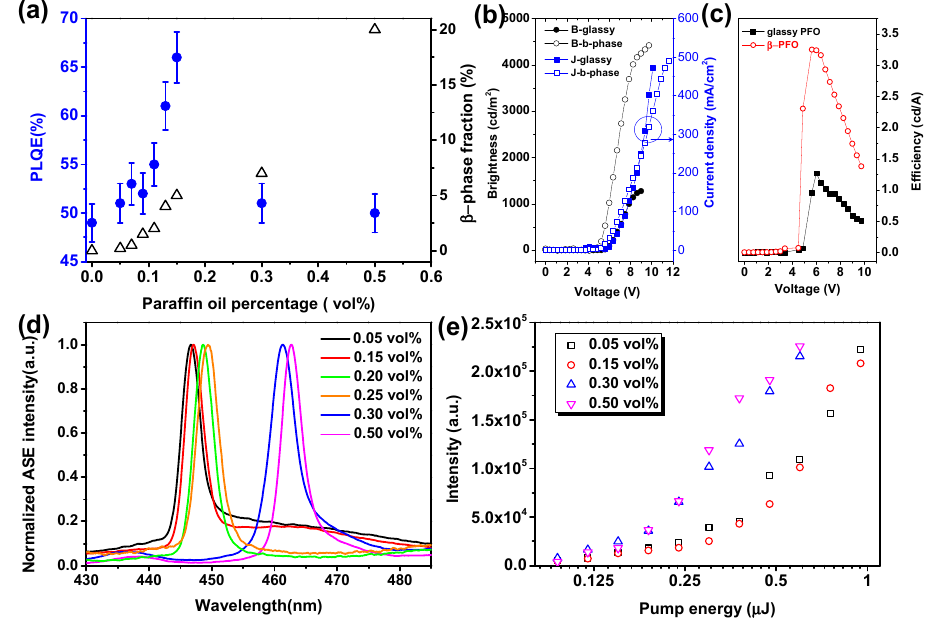
Figure 4. ( a ) PLQE (filled circles) and β -phase fractions (open triangles) of PFO films as a function of paraffin oil volume percentage. ( b ) J–V–B curves and ( c ) the current efficiencies as a function of the input voltage for LEDs based on pristine PFO and mixed phase PFO films ( β -phase fraction 2%). ( d ) ASE spectra of mixed phases PFO films spin-coated from various mixtures with paraffin oil volume percentages: 0.05, 0.15, 0.20, 0.25, 0.30, and 0.50 vol % ( β -phase fraction 0.2, 5, 5.3, 5.7, 7, 20%). ( e )